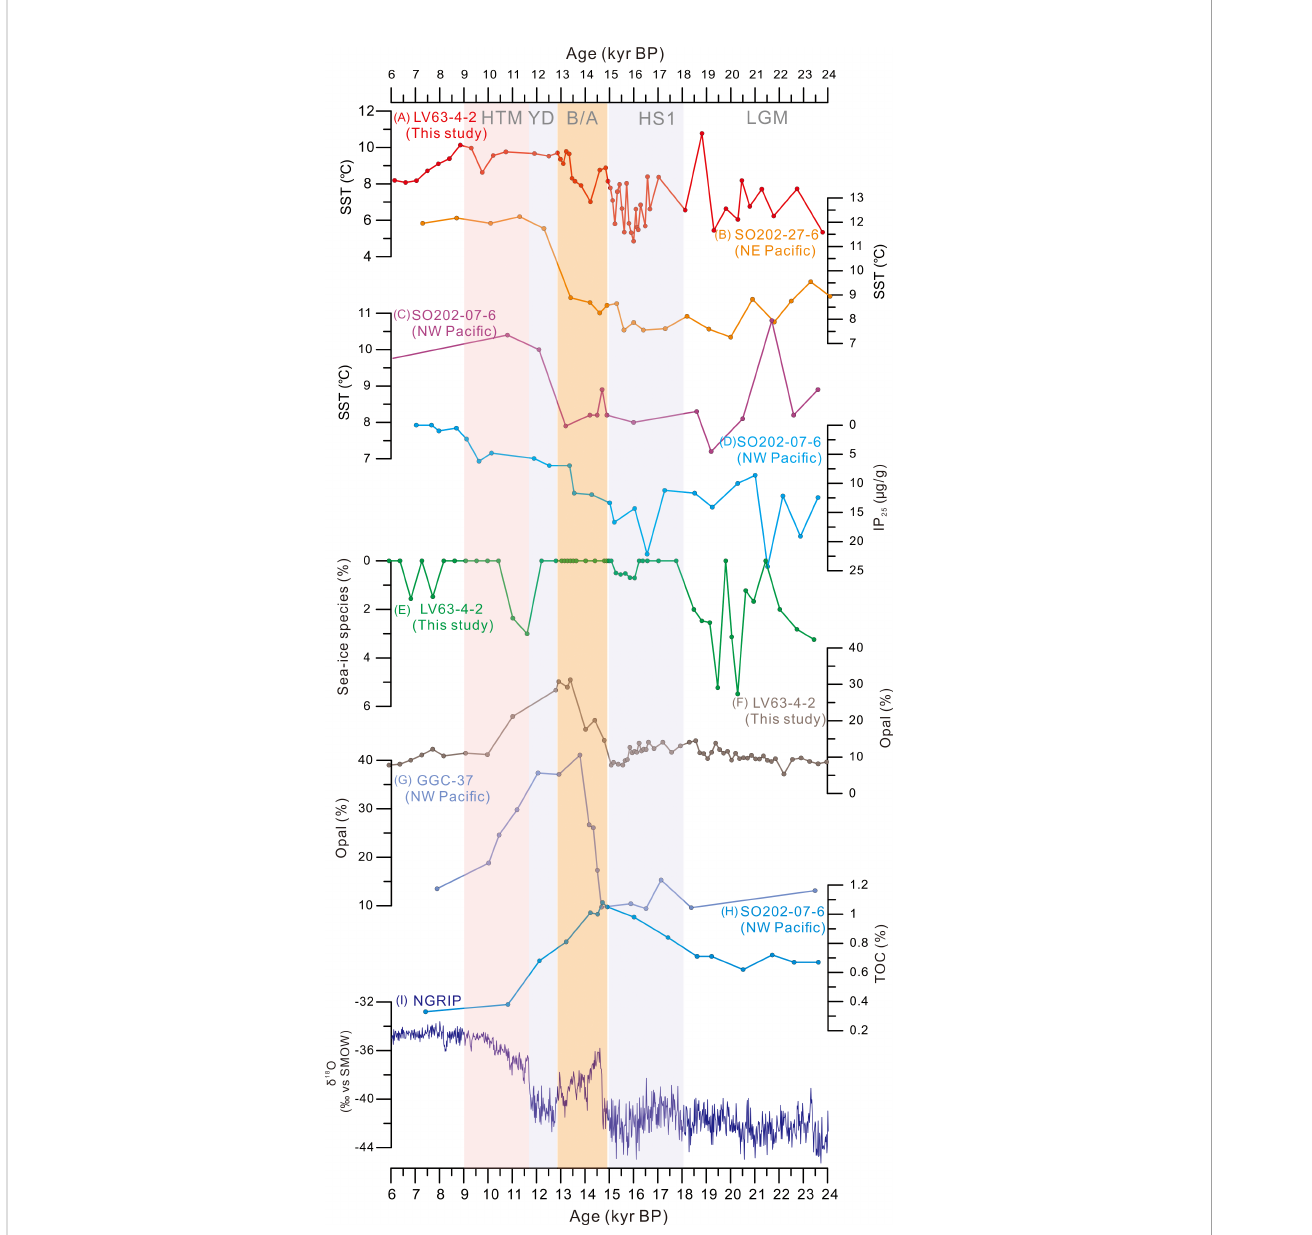
FIGURE 4 Comparison of paleoenvironmental proxies between core LV63-4-2 and other regional records. (A – C) : Sea surface temperature (SST) records from cores LV63-4-2, SO202-27-6 (Maier et al., 2015), and SO202-07-6 (Serno et al., 2015). Sea-ice proxies: (D) Ice proxy 25 (IP 25 ; m g/g) concentration from core SO202-07-6. (E) Abundance of sea-ice diatom species from core LV63-4-2. Paleoproductivity proxies: (F) Opal concentration (%) from core LV63-4-2; (G) Opal content (%) of core GGC-37 (Keigwin et al., 1992); (H) Total organic carbon (TOC; wt.%) from core SO202-07-6 (Serno et al., 2015); and (I) d 18 O record of the North Greenland Ice Core Project (NGRIP) ice core ( ‰ ; Rasmussen et al.,